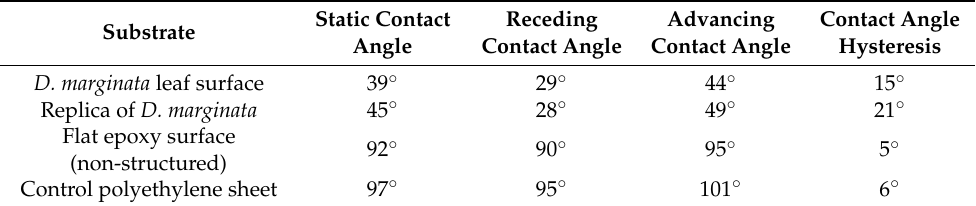
Figure 5. Contact angles of water ( a ) on the D. marginata leaf surface, ( b ) replica of the D. marginata leaf surface, ( c ) flat epoxy surface (non-structured) and ( d ) control polyethylene sheet. Table 1. Water contact angle mean values for the adaxial surface of the D. marginata leaf, its replica and control